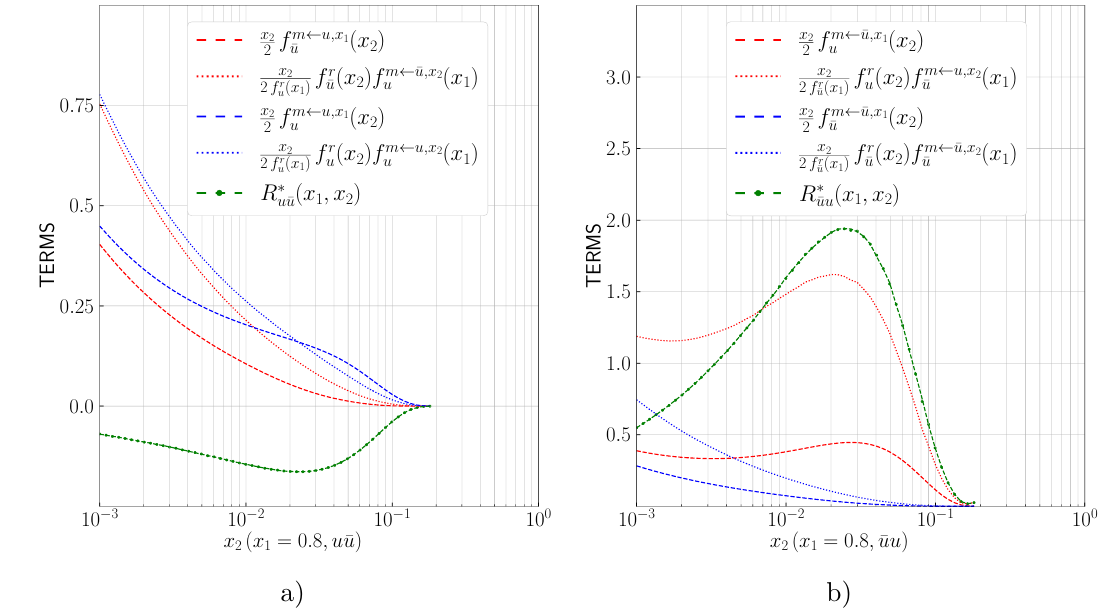
Figure 5 . Different terms contributing to a) R ∗